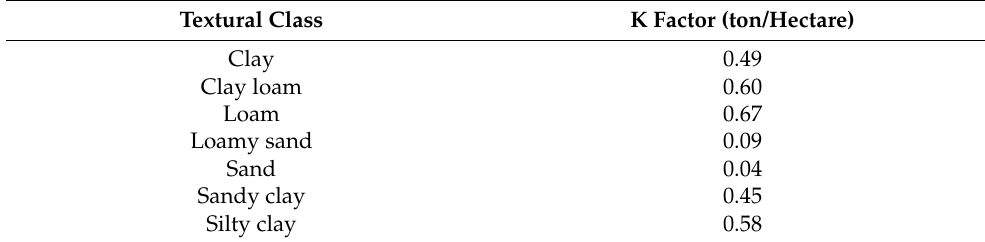
Table 1. Soil features and the corresponding K factor. Textural